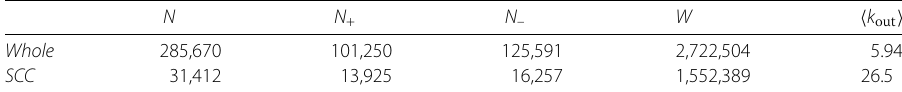
Table 1 Main properties of aggregated PC network and its largest strongly connected component (SCC): number of users N , with overall positive (negative) values of political position N + ( N – ), total number of interactions W , and average out-degree (cid:2) k out (cid:3) . See Table S8 in SI for the PC network obtained from a different hashtag classification N N + N – W (cid:2) k out (cid:3) Whole 285,670 101,250 125,591 2,722,504 5.94 SCC 31,412 13,925 16,257 1,552,389